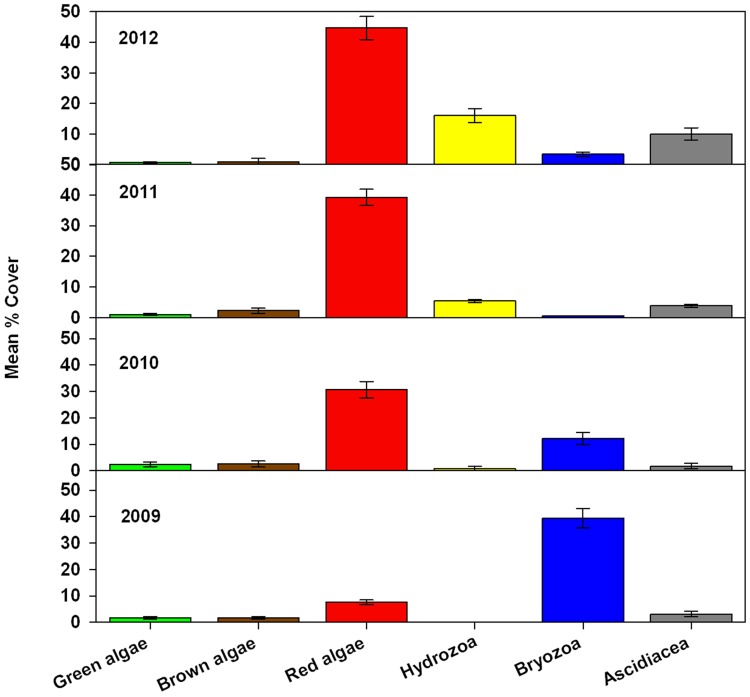
Mean cover of main groups of epibiota on the ASR 2009–2012.Data is mean of vertical and horizontal surfaces. Data from 2009 obtained in December, other years in October. Error bars show +SE.